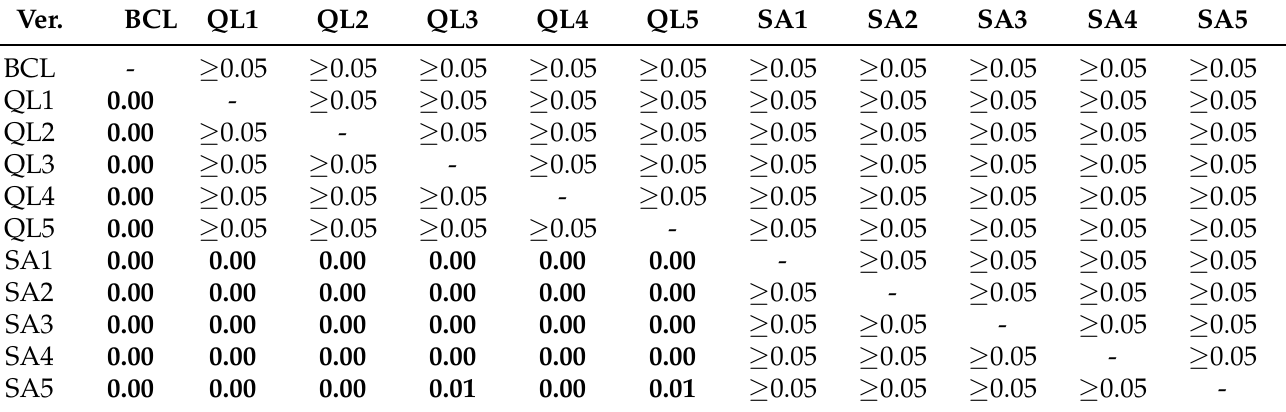
Table 15. The average Wilcoxon–Mann–Whitney test of